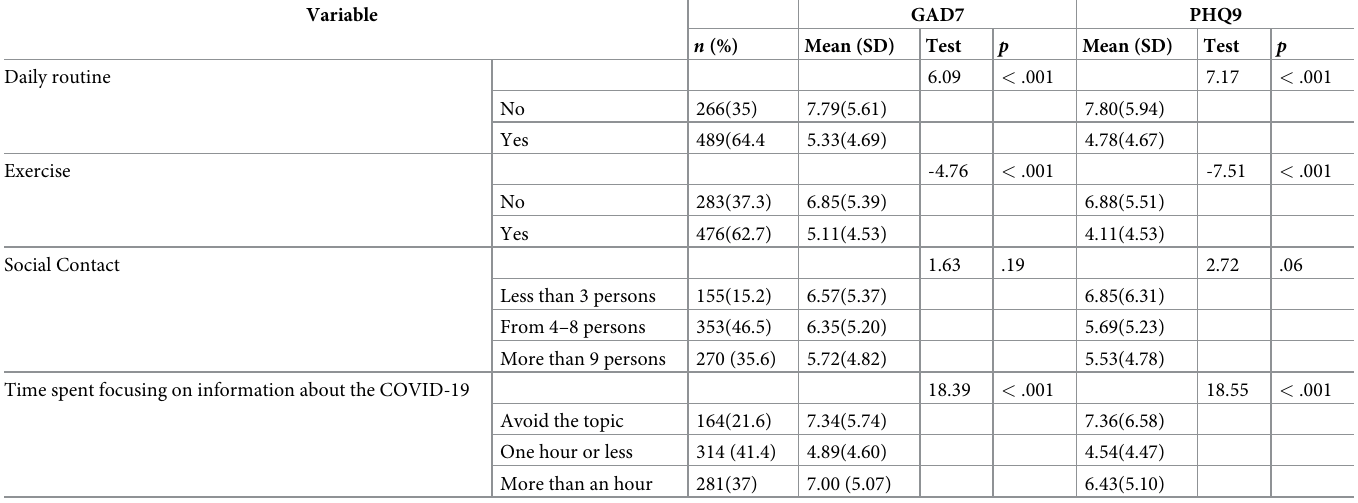
Table 2. Behaviors during confinement and group differences of GAD-7 and PHQ-9 total sum